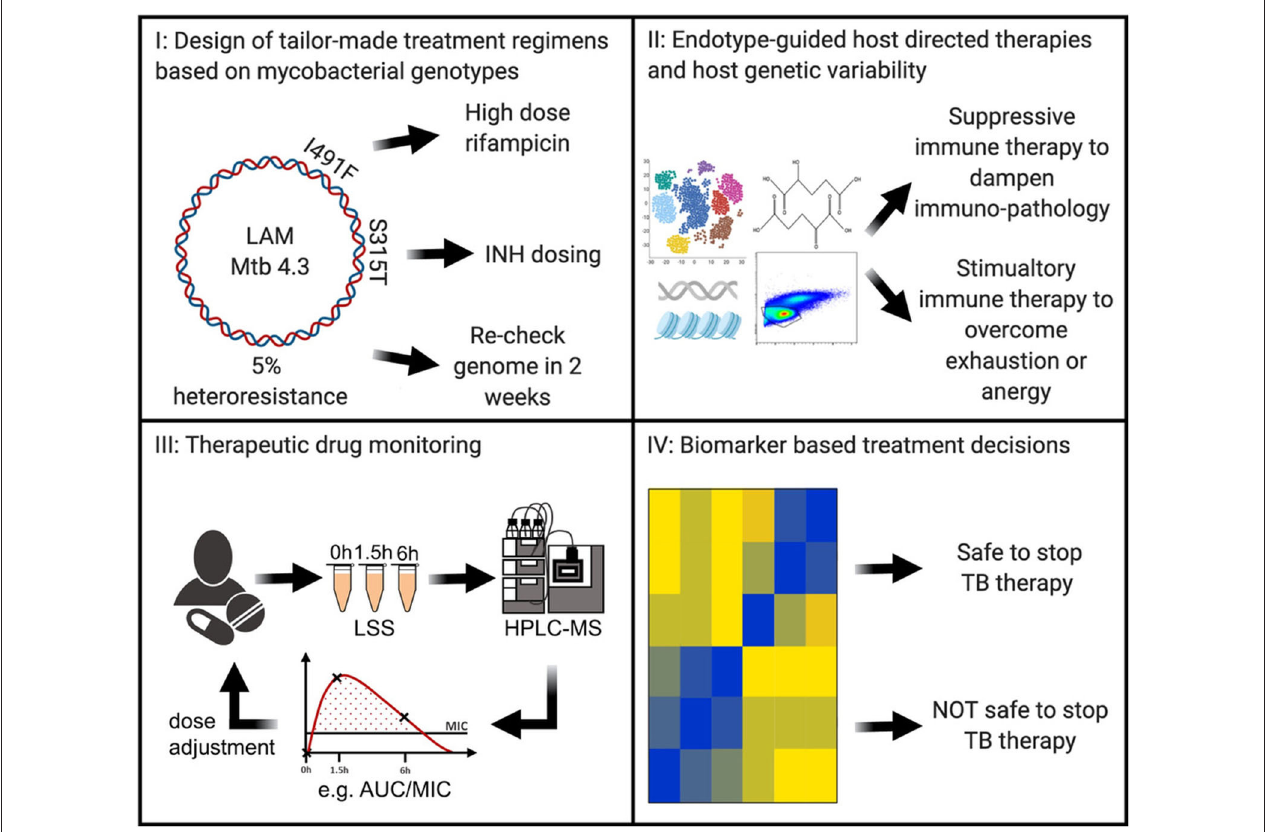
FIGURE 1 | In the near future, Precision Medicine for tuberculosis will likely include (I) antibiotic regimens based on next-generation sequencing of the Mycobacterium tuberculosis genome to guide tailor-made therapies; (II) evaluation of gene expression, genetic, epigenetic, metabolism, and/ or immune phenotyping to discern the host endotype with endotype-specific host directed therapies to shorten and improve clinical outcomes; (III) individualization of antibiotic dosing through therapeutic drug monitoring; (IV) in treatment biomarker levels to customize therapy duration. LAM, lipoarabinomannan; Mtb, Mycobacterium tuberculosis ; INH, isoniazid; LSS, limited sampling strategy; HPLC-MS, high-performance liquid chromatography-mass spectrometry; AUC, area under the curve; MIC, minimal inhibitory concentration; TB,